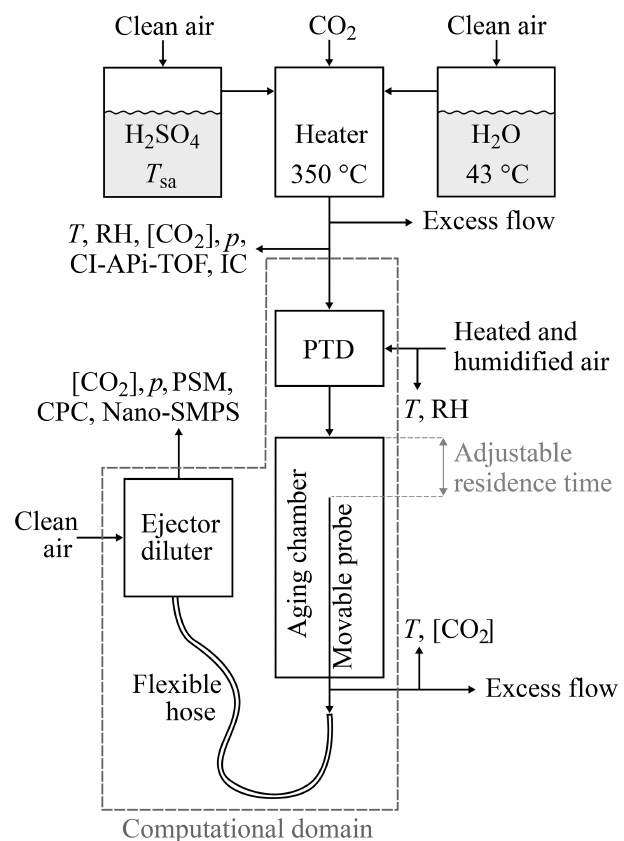
Figure 1. The experimental setup used to generate artificial exhaust and sample it with a diluting sampling system. The top part of the figure represents the artificial raw exhaust generation, which con- tains mixing and heating H 2 SO 4 and H 2 O vapors evaporated from liquids. The bottom part of the figure represents the raw exhaust sampling system, which consists of a porous tube diluter (PTD), an aging chamber, and an ejector diluter. The computational domain of the CFD simulation is also shown in the